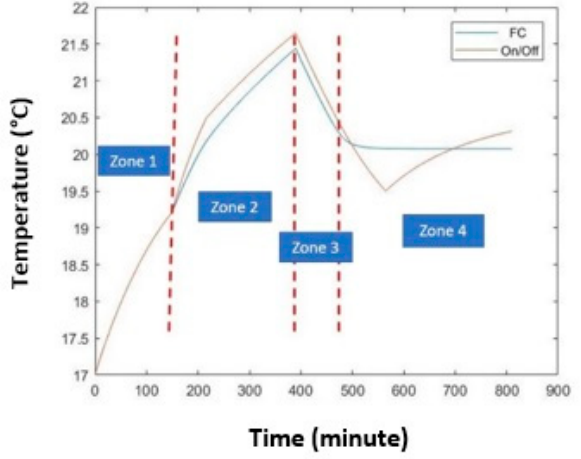
Figure 16. Temperature evolution in a practical classroom with a large size by using a FC and On/Off controller. Zone: It remarks different conditions during the experiments.